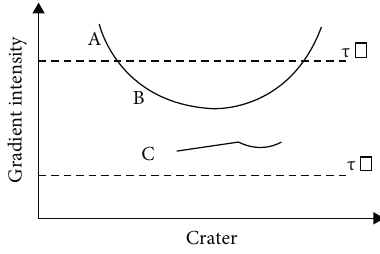
Figure 1: Crater edge extraction method by the Canny edge